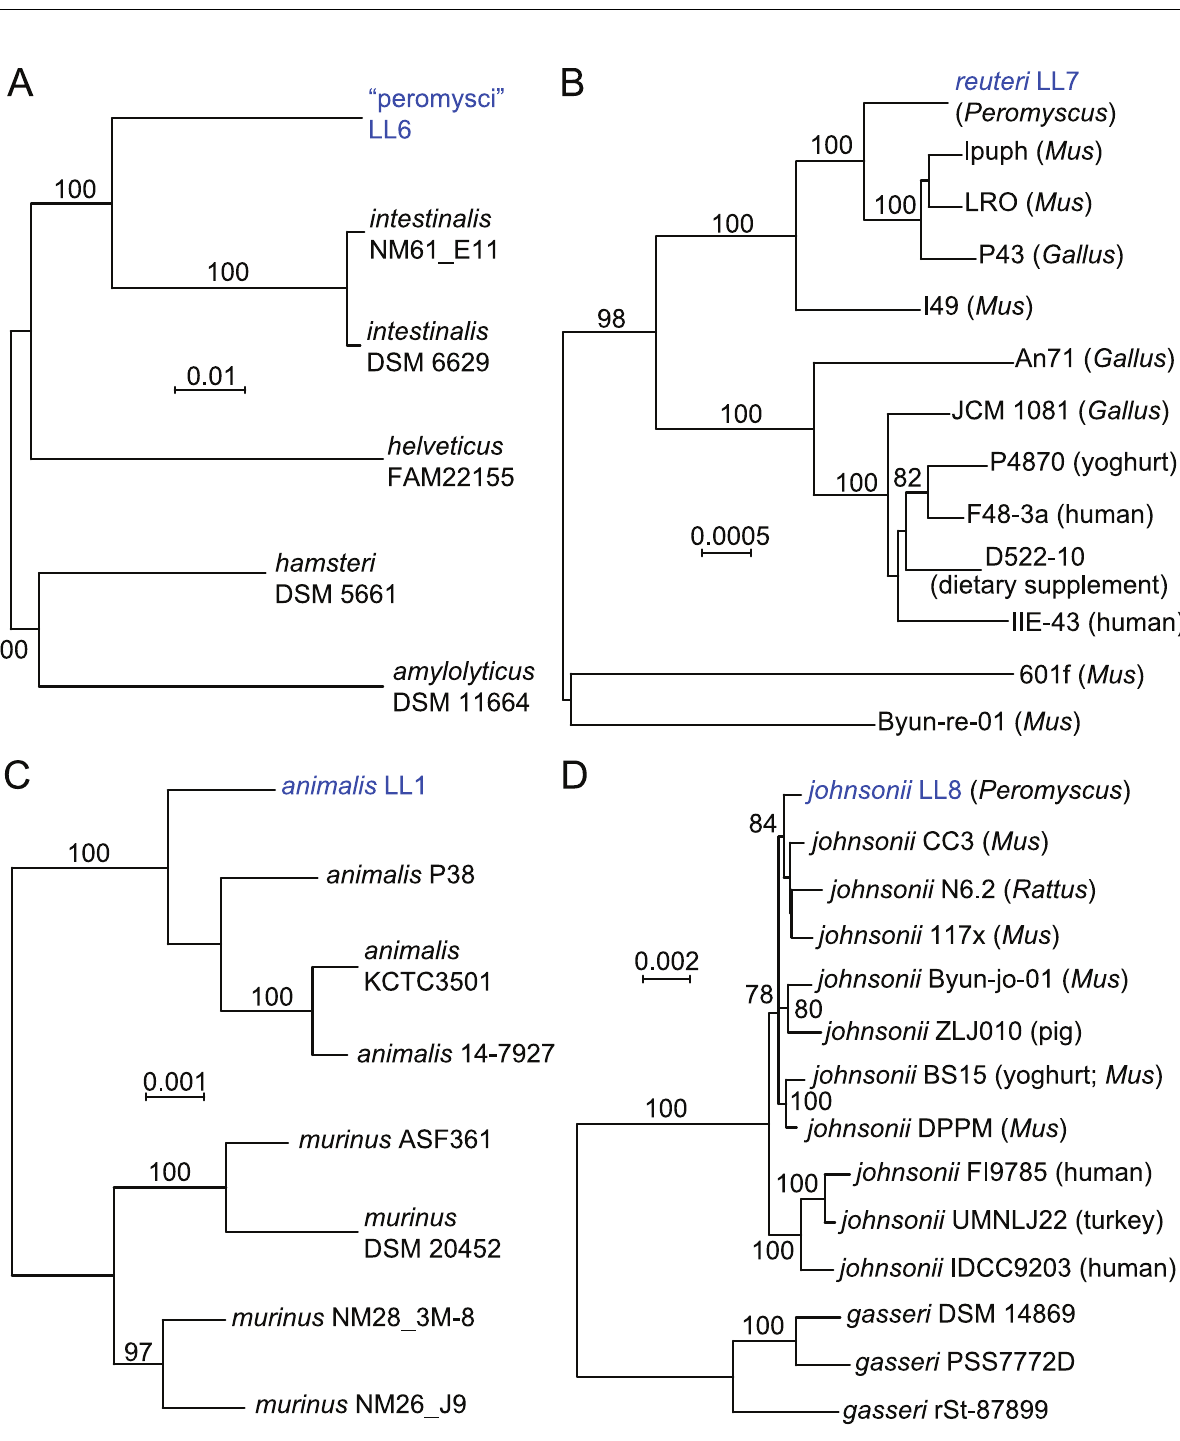
PLOS ONE | https://doi.org/10.1371/journal.pone.0231801 August 20,